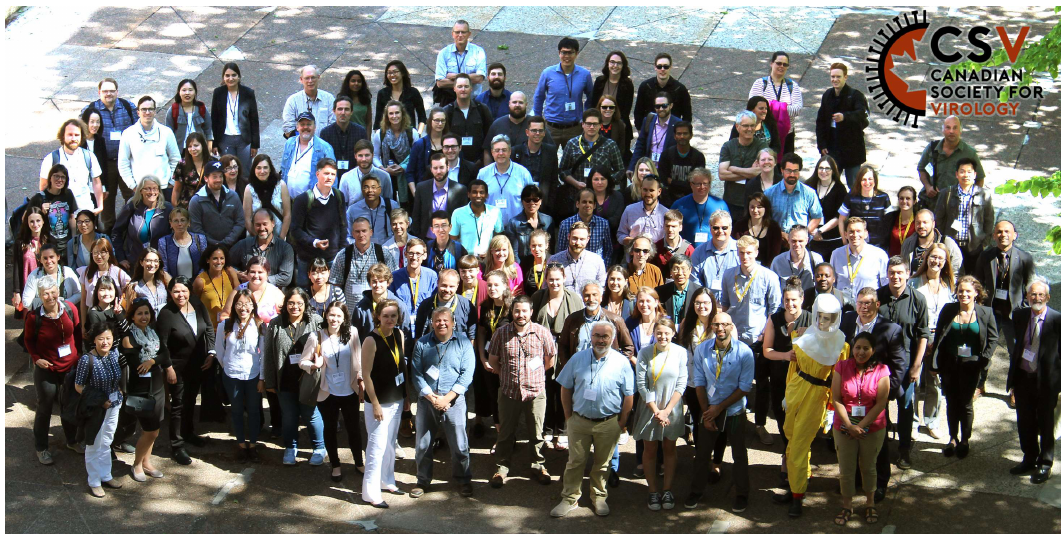
Figure 4. CSV2018 Group Photo.